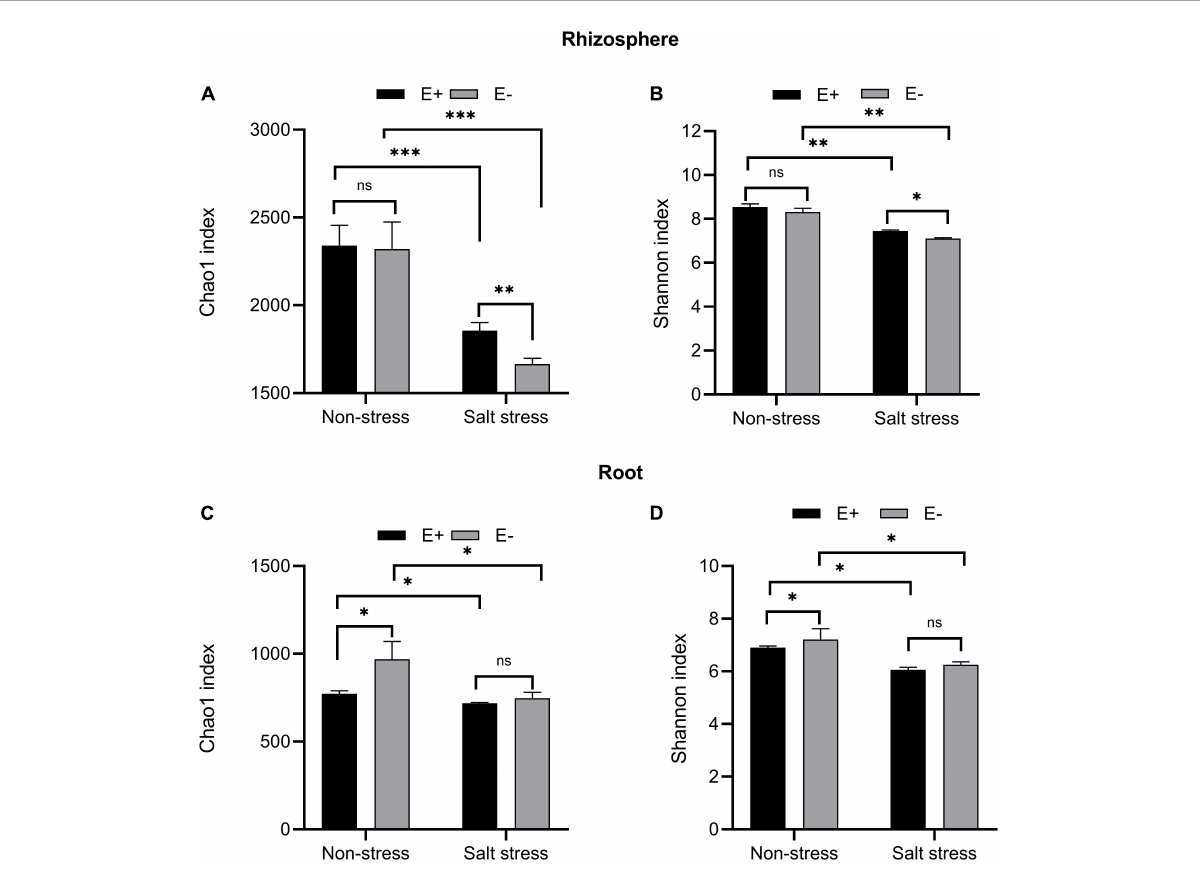
FIGURE7 Alpha diversity. Bacterial diversity and richness in rhizosphere soil (A, B) and root (C, D) . Bars denote means ± SE of four treatment. “Non-stress” represents bermudagrass grown without NaCl condition; “Salt stress” represents bermudagrass under 250 mM salt conditions. “E + ” represents the infection of Enterobacter ludwigii , “E–” represents the absence of E. ludwigii. “ ∗ ,” “ ∗∗ ,” “ ∗∗∗ ” indicate significant differences at P < 0.05, P < 0.01, and P < 0.001, respectively, and ‘ns’ represents no significant